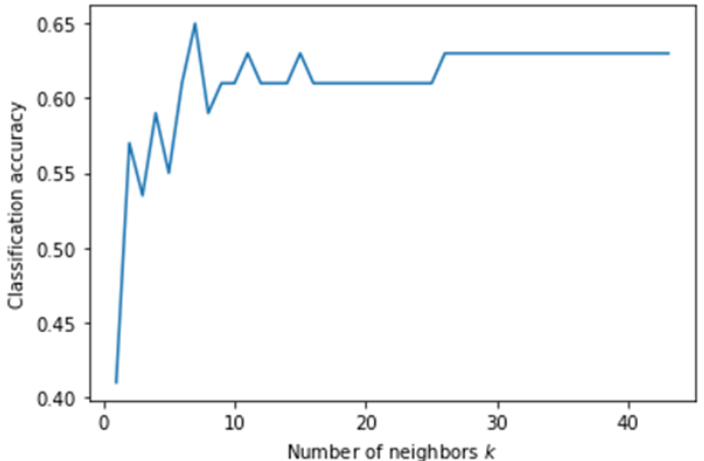
Figure 12. Classification accuracy according to k parameter of KNN on Dataset 06 when classifica- tion was based on smoking habits. was based on smoking